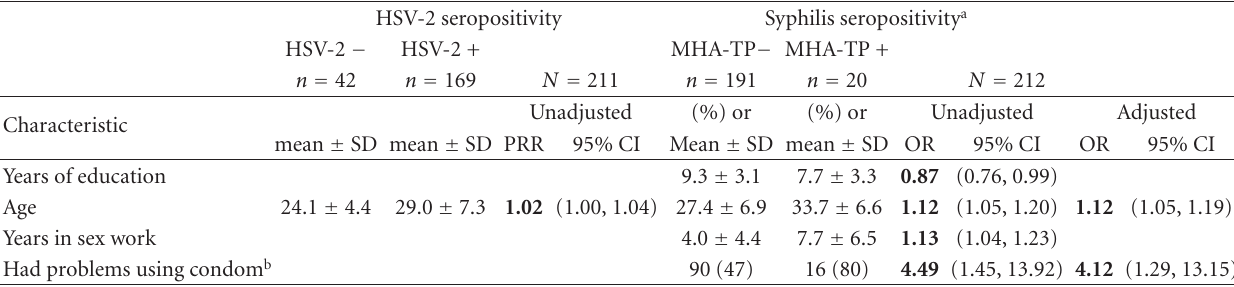
Table 5: Bivariate analyses of relationships between individual behavioral characteristics and risk of HSV-2 herpes and syphilis, among 212 clandestine female sex workers: Lima, Peru,